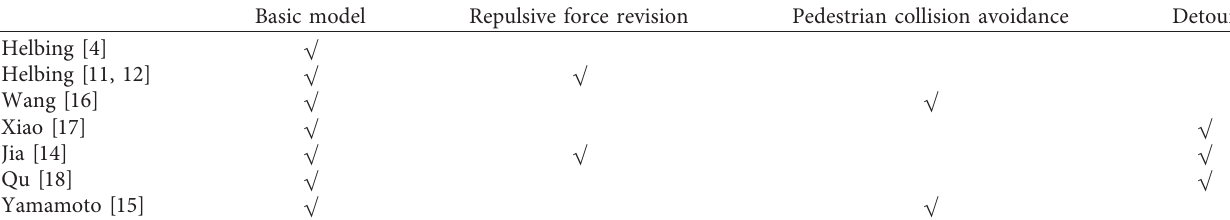
Table 1: Comparison of current research about the social force